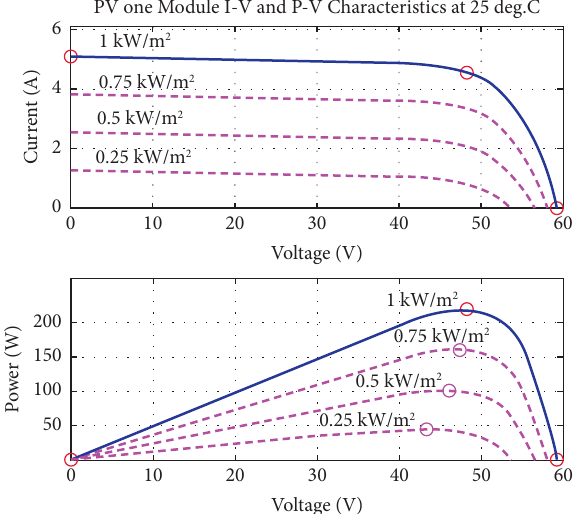
Figure 2: I--V and P-V characteristics of 218W PV panel.